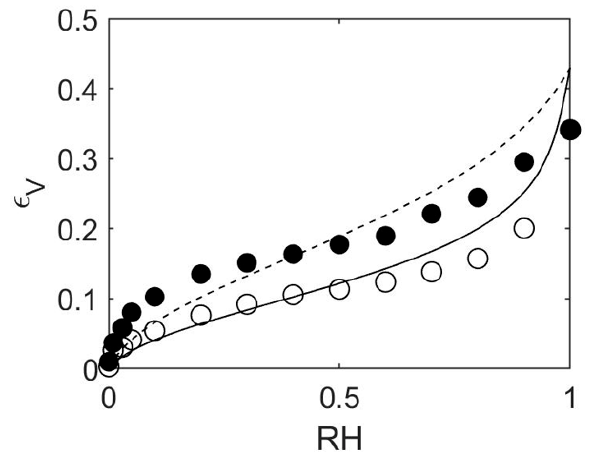
Figure 8. Comparison of results between continuum model based on upscaling and molecular simulation. The open and closed dot represents the strain isotherm of amorphous cellulose from the molecular simulation upon adsorption and desorption respectively. The solid and dashed lines represents strain isotherm modeled by continuum model upon adsorption and desorption respectively.